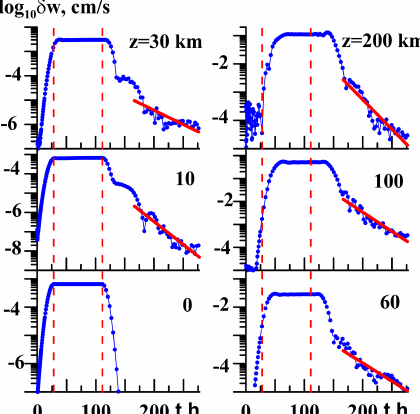
Figure 2. Time variations in standard deviations of the wave ver- tical velocity at different altitudes (marked with numbers) for the steep activation and deactivation of the surface wave source (Eq. 5) at c x = 50ms − 1 and W 0 = 0.01mms − 1 . Dashed lines correspond to t = t a and t = t d in (Eq. 7). Solid lines show exponential